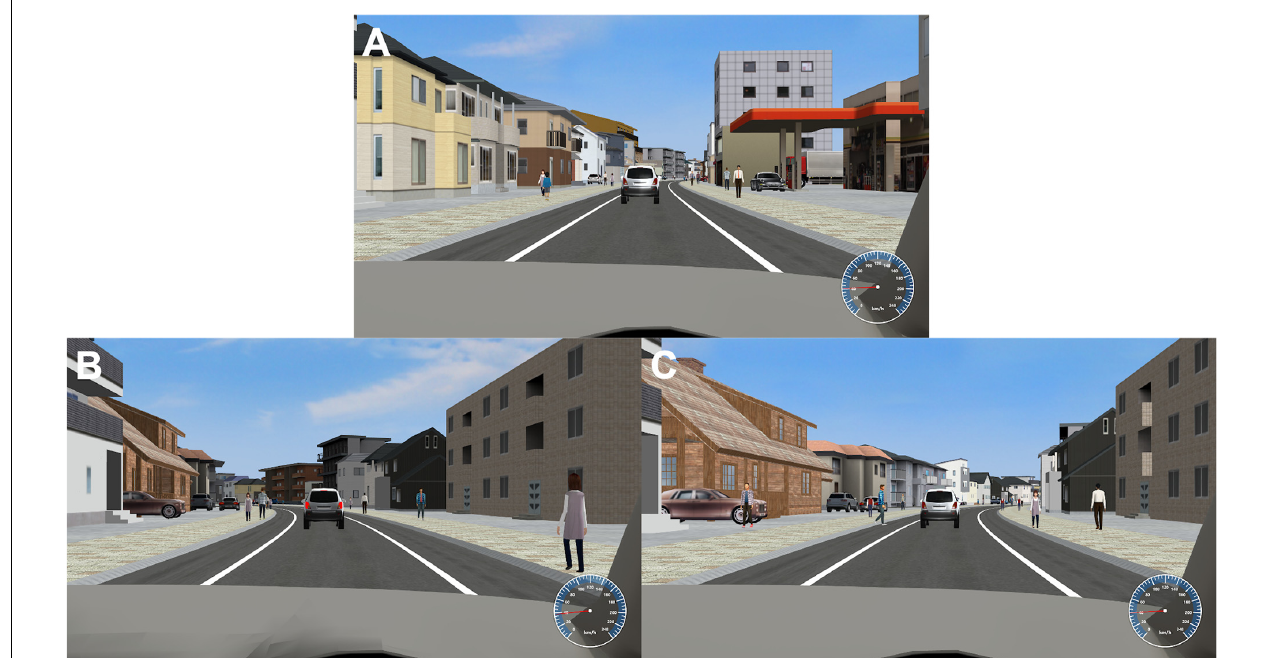
FIGURE 1 | Driving simulator and emergency events. (A) While driving along a gently S-shaped road, participants were asked to control the car so that it was positioned in the center of the road as much as possible (driving accuracy) by pushing the left and right buttons of an MRI-compatible response button. They were also asked to perform braking responses to two types of emergency events: (B) deceleration of the vehicle ahead (the brake lights of the vehicle ahead would glow) and (C) a pedestrian moving from the sidewalk on the right or left toward the road (in this case, a man in a blue shirt is walking toward the road).